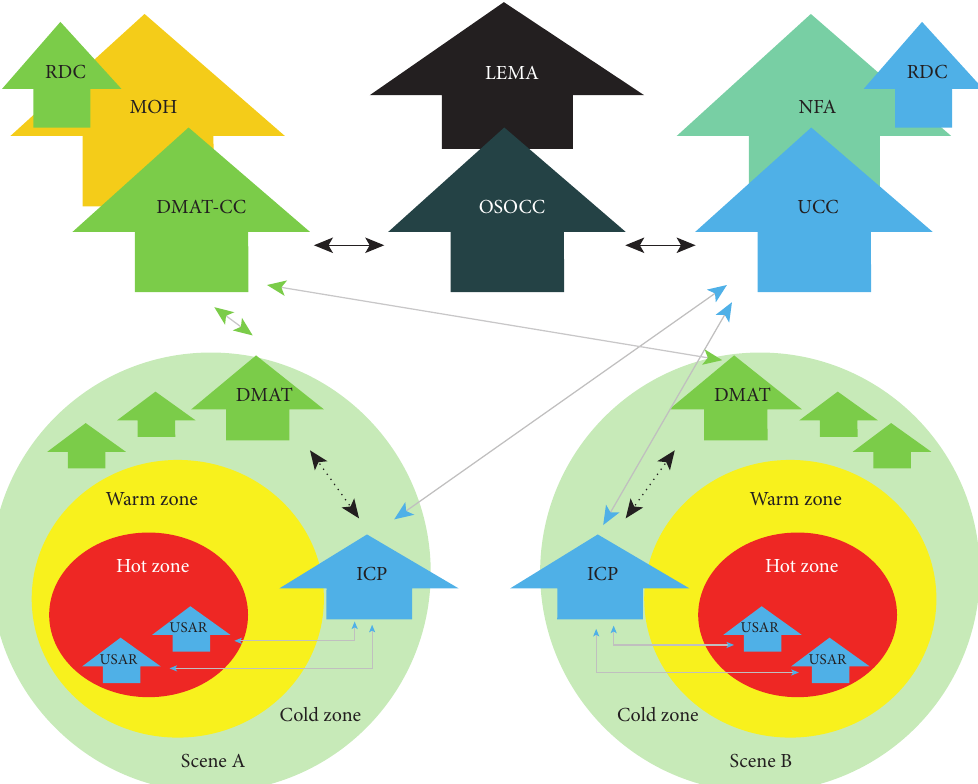
Figure 1: The command and coordination system of this exercise. RDC: Reception and Departure Center; MOH: Ministry of Health; DMAT: disastermedicalassistanceteam;DMAT-CC: DMATcoordinationcell; USAR:urbansearchandrescue;UCC:USAR coordinationcell;LEMA:local emergency management agency; NFA: National Fire Agency; OSOCC: on-site operation coordination cell; ICP: incident command